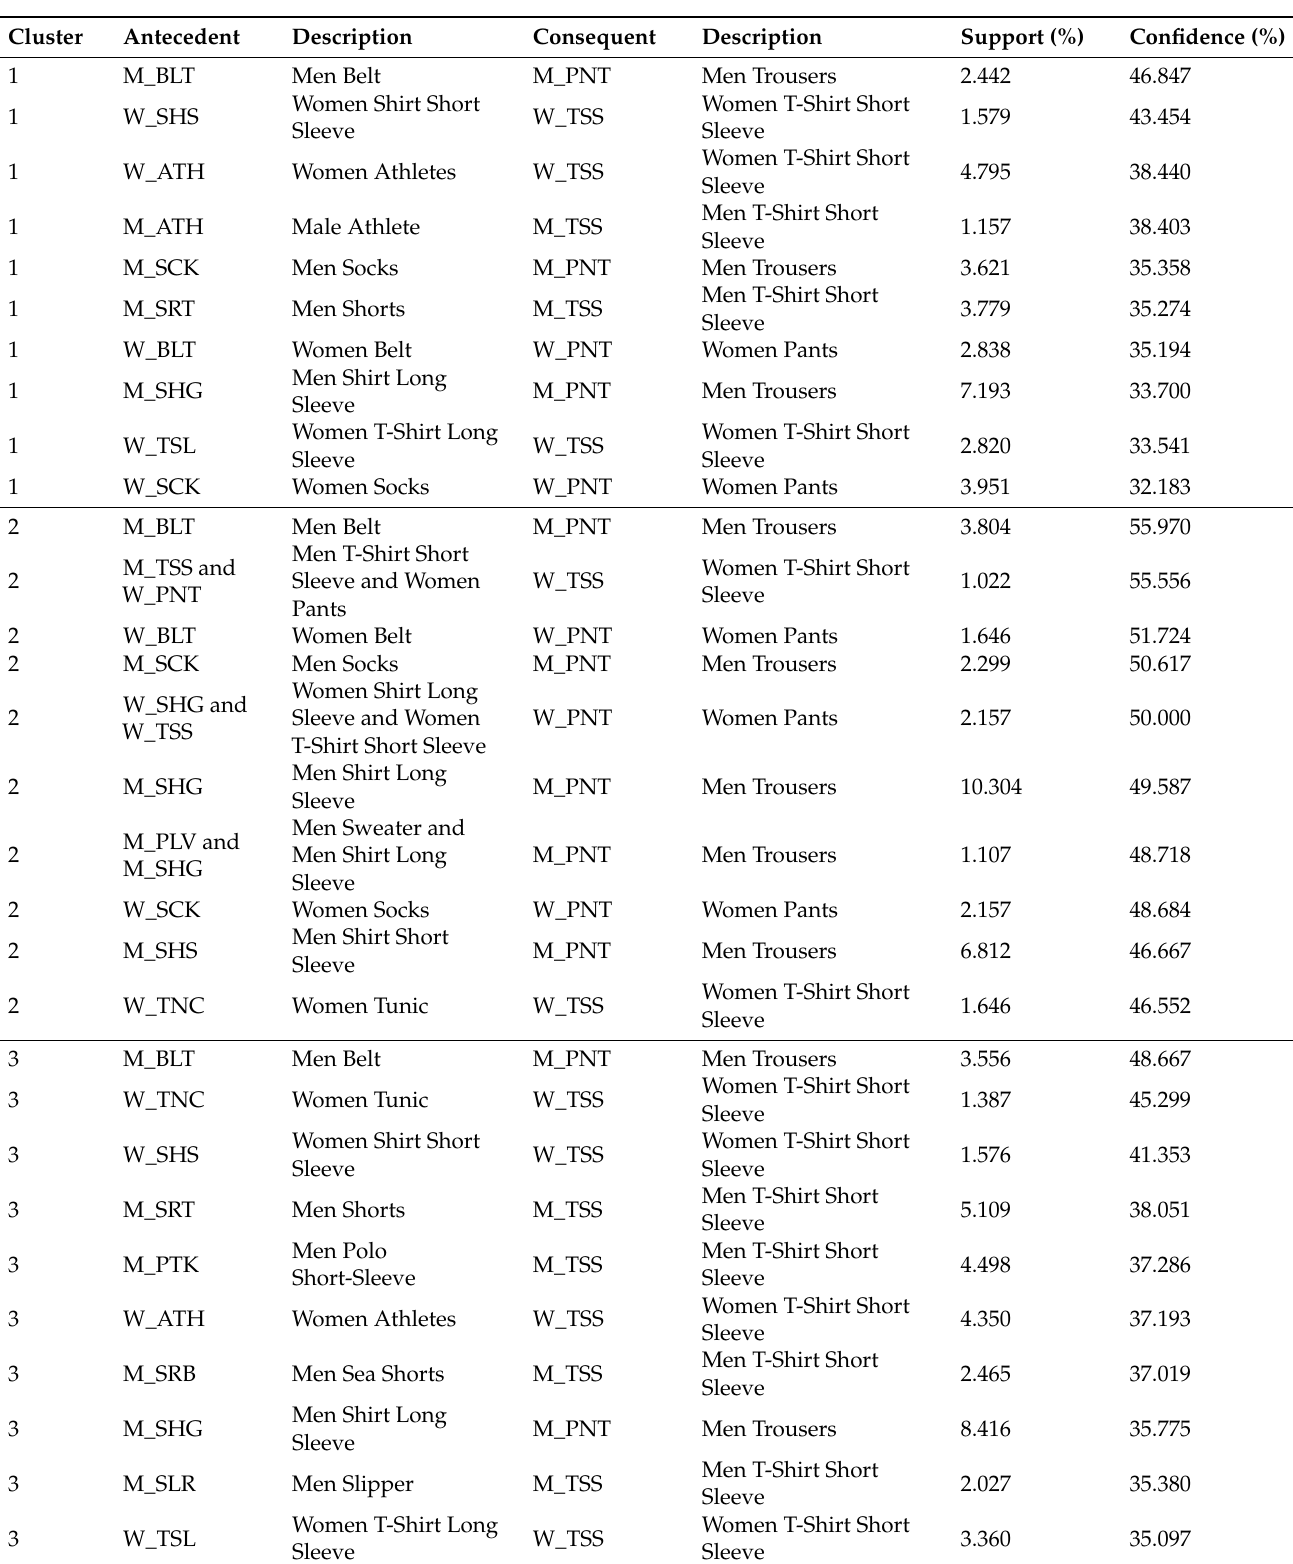
Table 3. Top ten association rules identified for customer